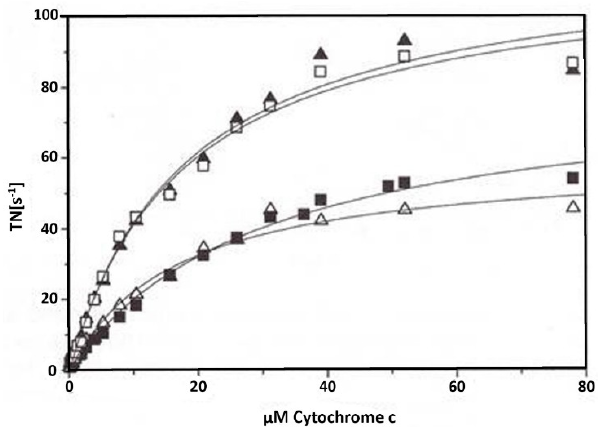
Figure 4. Dependence of cholate-CytOx activity on the time of incubation in the presence of nucle- otides: The 0.1 μ M concentration of bovine heart CytOx was incubated for 24 h at 0 °C in 50 mM potassium phosphate (pH 7.4), 1 mM EDTA, and 1% Tween 20. Incubation with 5 mM ATP ( ■ ) or 5 mM ADP ( ▲ ) results in lower or higher activities, respectively. Furthermore, just before activity measurements, the addition of 5 mM ADP into the ATP incubated sample results instantly in the removal of the inhibitory effect ( □ ). Contrarily, the addition of 5 mM ADP into the cholate-CytOx sample just before measurement ( ∆ ) shows that the enzymatic activity remains low, which is comparable to the activity measured in the presence of ATP. Here it is obvious that ADP cannot immediately replace the cholate at the binding sites of the enzyme. TN = turnover number (mole O 2 s − 1 /mole heme aa 3 ).